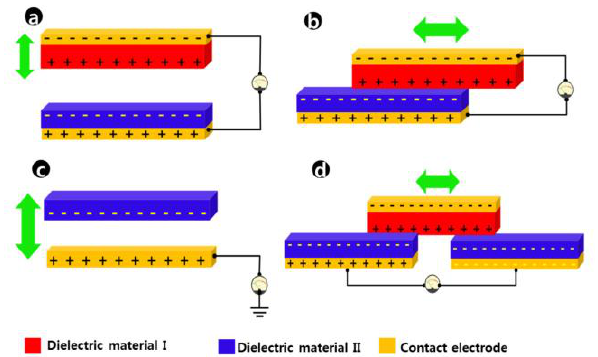
Figure 32. Triboelectric nanogenerators (TENGs) and their chief functioning modes: ( a ) vertical contact–separation mode, ( b ) lateral sliding mode ( c ) single-electrode mode, and ( d ) freestanding triboelectric-layer mode (reproduced from reference [251] with permission. Copyright 2018, Elsevier). Polyvinylidene fluoride (PVDF), a semicrystalline polymer with alternating hydrogen and fluorine